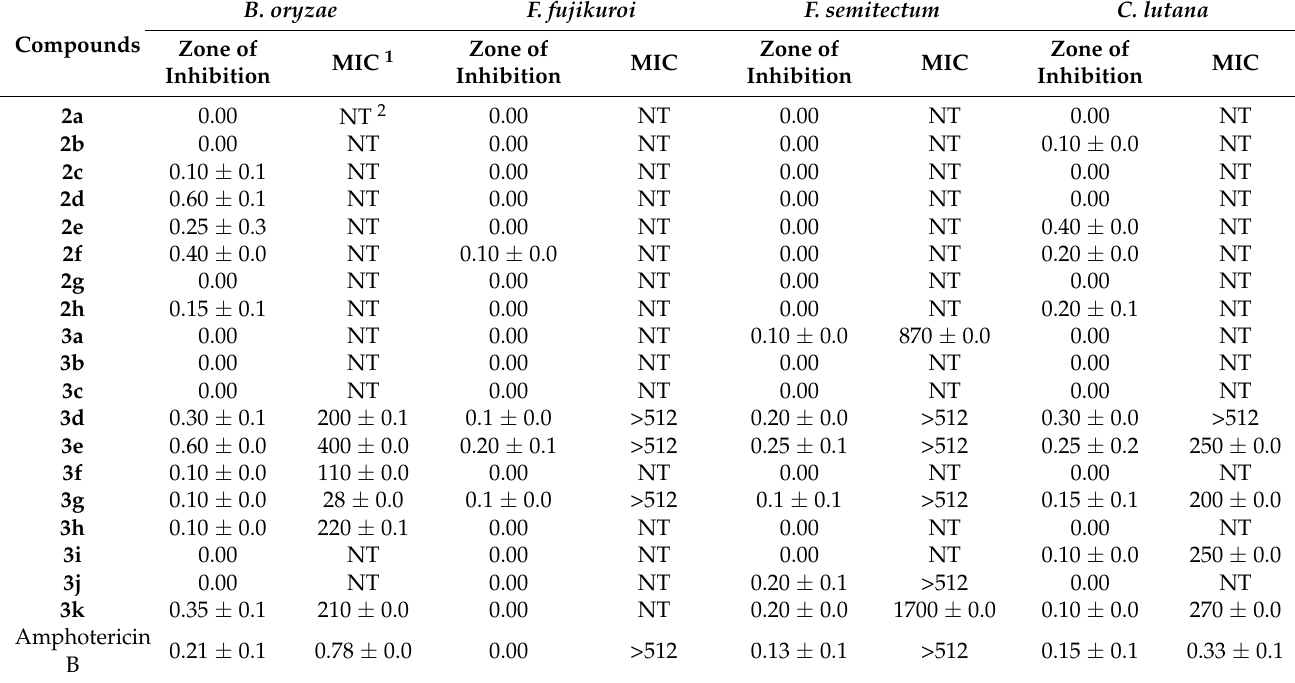
Table 1. In vitro zones of inhibition (cm) and minimum inhibitory concentrations ( µ g/mL) of the THßC derivatives on phytopathogenic fungi.